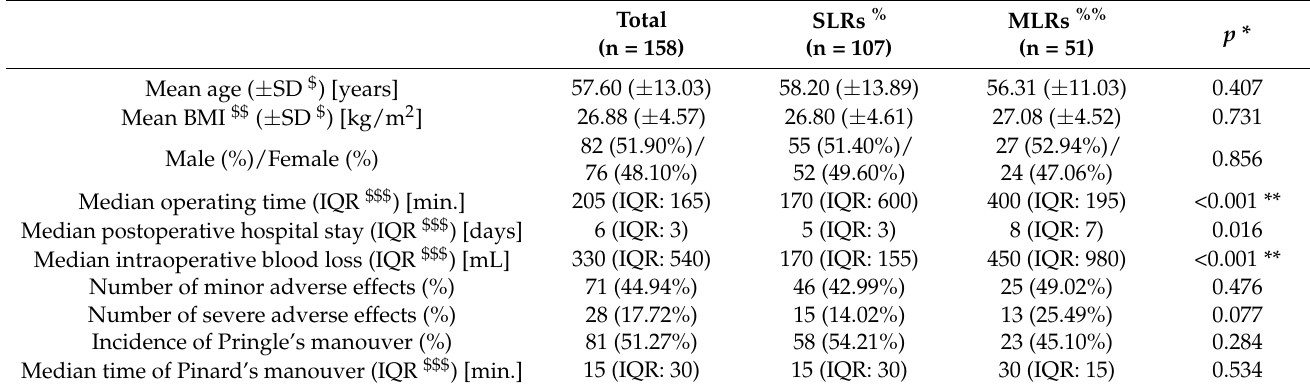
Table 1. Baseline characteristics of patients and